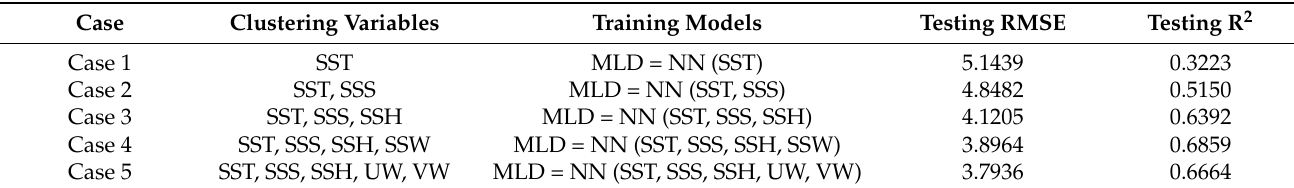
Table 4. The RMSE and R 2 values of Case 1 to Case 5.